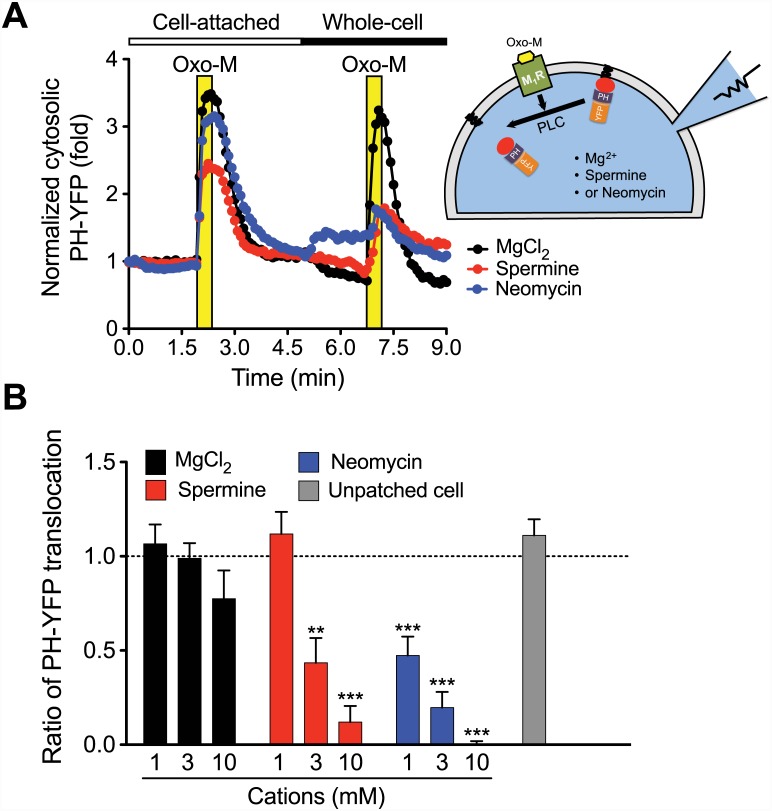
Inhibition of PIP2 hydrolysis by Mg2+, spermine, or neomycin dialyzed into cells through patch pipette.(A; Right) HEK293-tsA201 cells were transfected with M1R and PH-YFP and dialyzed cations through whole-cell patch pipette. (Left) The average rate of PIP2 hydrolysis by PLC was estimated as Fig 1. The first Oxo-M response was triggered while being in cell-attached mode. For accumulation of the cations, the membrane patch was ruptured to form the whole-cell configuration and the cations in the pipette solution were dialyzed into the cell. To accelerate the movement of the cations by electrophoresis, the voltage steps to +80 mV from -80 mV for 2 s were repeated. The effects of 3 mM MgC12 (N = 6), spermine (N = 5), and neomycin (N = 4) are shown. Error bars were omitted for clarity. (B) Summary of PLC activity after pipette perfusion of different concentrations of the cations. PIP2 hydrolysis in the neighboring unpatched cells was nearly unaltered. The results are mean ± SEM and representative of three independent experiments. N = 4–10 for each condition. ** P < 0.01 and *** P < 0.001 compared to 1 mM MgCl2 group (N = 10).